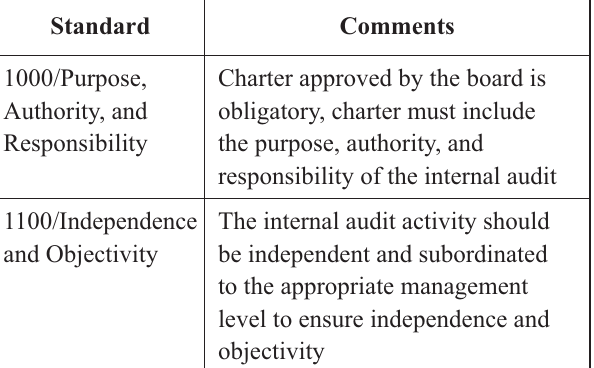
Table 1. Standards on Internal Auditing - summary [5] Standard